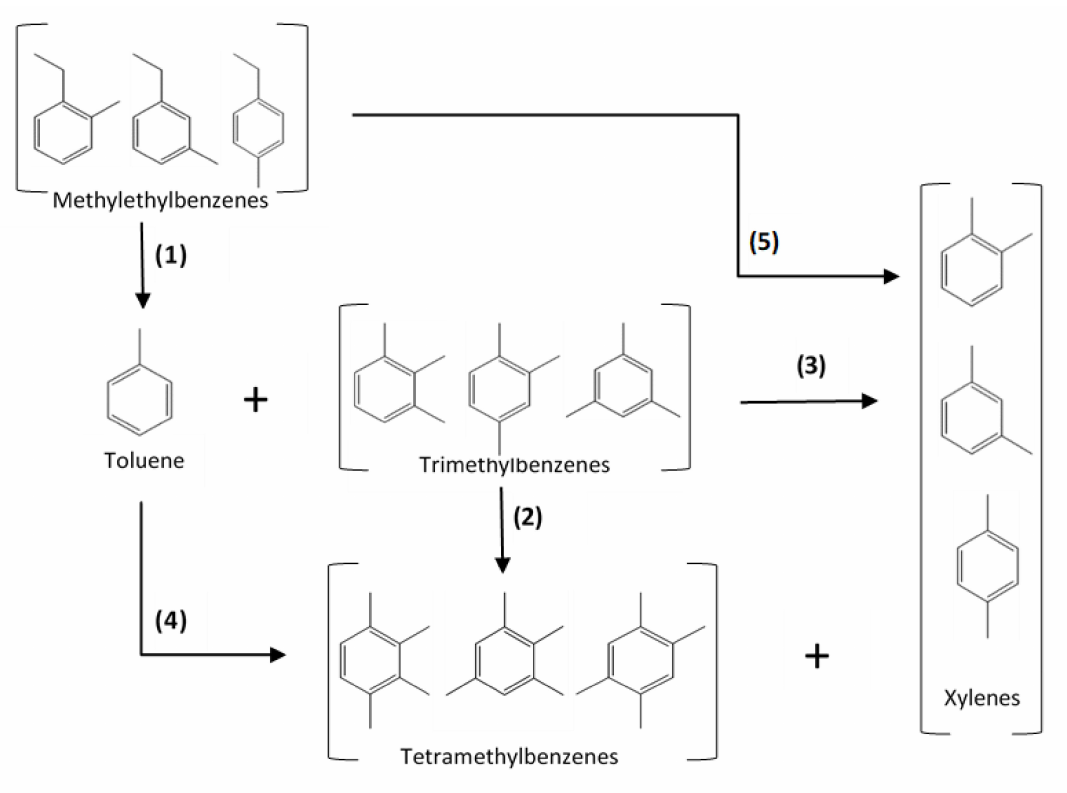
Figure 3. Simplified reaction network for kinetic modeling. Reactions (1) dealkylation of MEBs to form toluene; (2) disproportionation of TMBs to form TeMBs and xylenes; (3) transalkylation of toluene and TMBs to form xylenes; (4) paring reaction of TeMBs to form toluene; and (5) dealkyation of MEBs to form